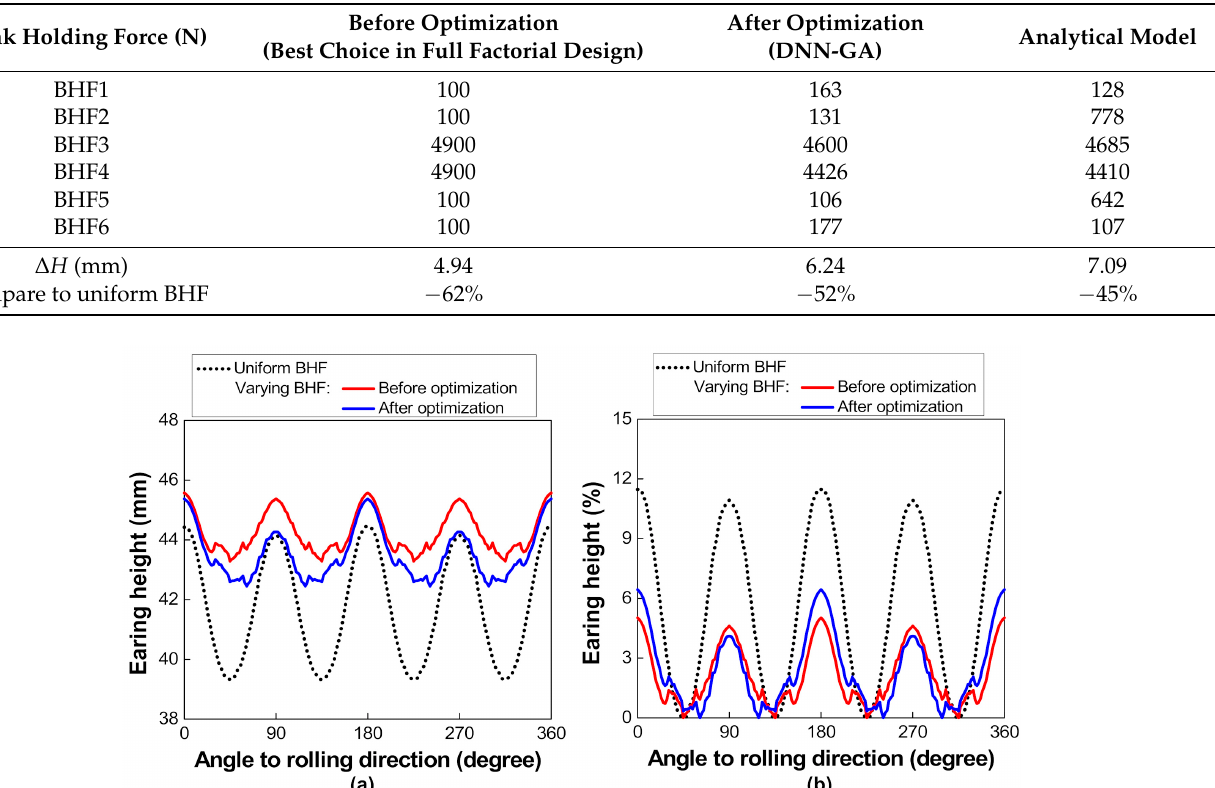
Table 3. Varying blank holding force (N) before and after optimization compared to the analytical model resulting in the reduction in earing height variation.